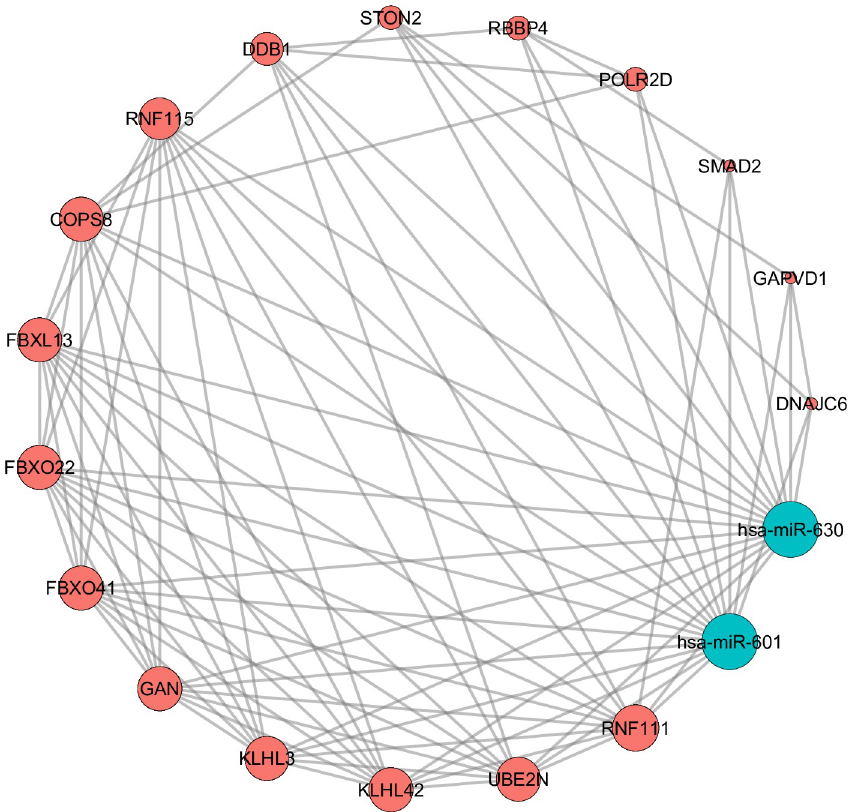
Fig 6. Candidate microRNA (miRNA)-mRNA target network constructed using Cytoscape. 17 genes (Nodes degrees > 6.0) and two miRNAs (miR-601 and miR-630) in module.